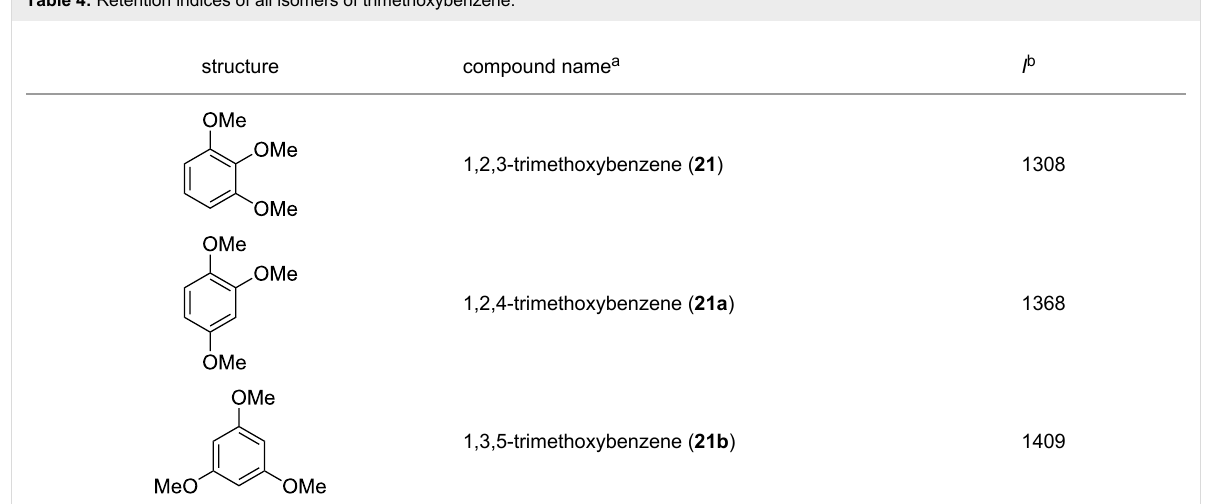
Table 4: Retention indices of all isomers of